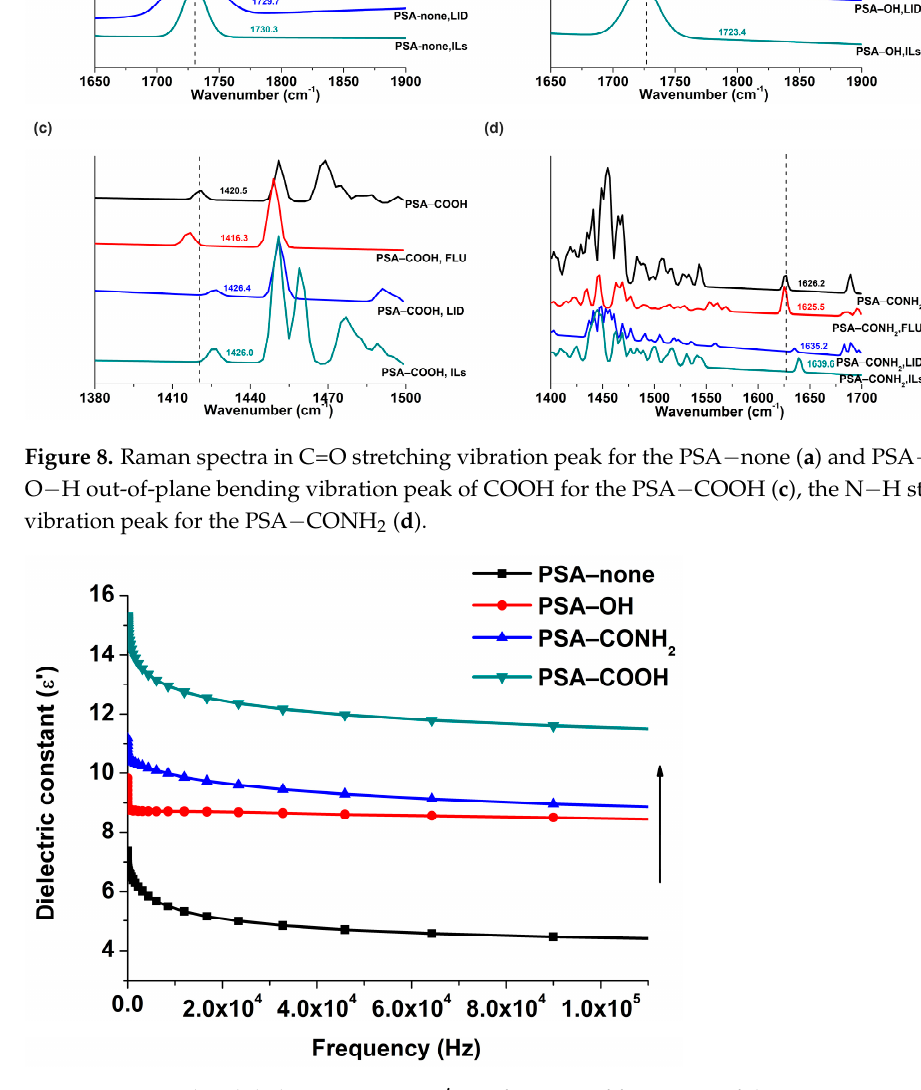
Figure 8. Raman spectra in C=O stretching vibration peak for the PSA − none ( a ) and PSA − OH ( b ), O − H out-of-plane bending vibration peak of COOH for the PSA − COOH ( c ), the N − H stretching vibration peak for the PSA − CONH 2 ( d ).